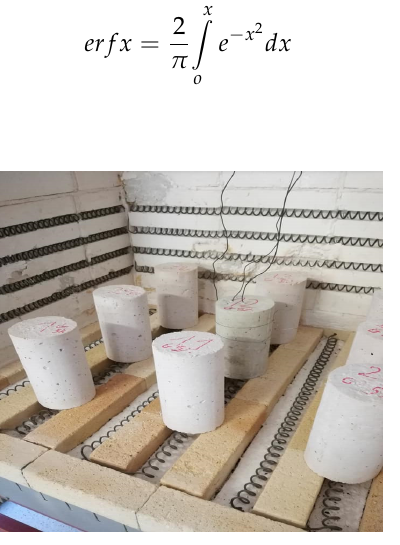
Figure 3. View of cylindrical samples before temperature loading, thermocouple fixing.